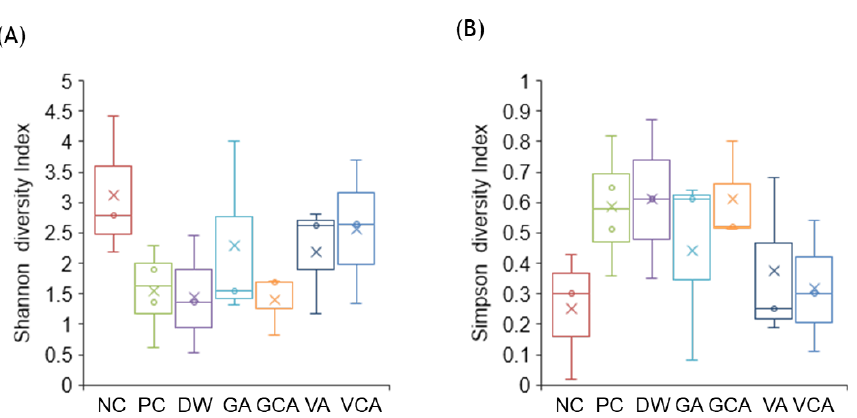
Figure 5. Alpha diversity of the oral microbiome. Boxplots show the Shannon diversity index ( A ) and the Simpson diversity index ( B ).